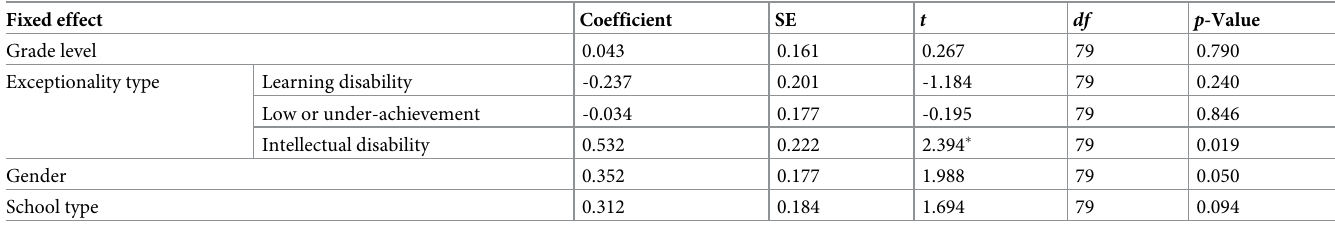
Table 11. Results of the conditional model with participant-related variables as predictors.